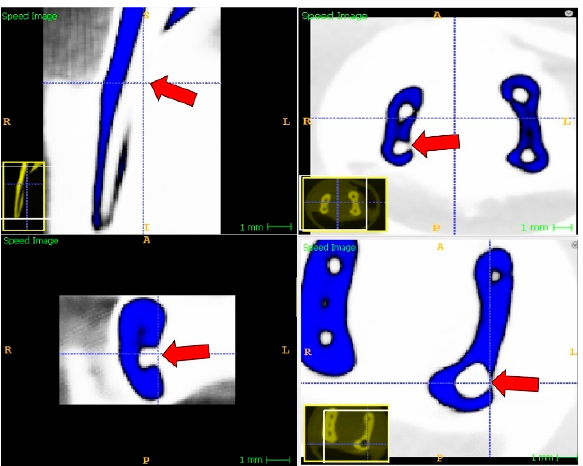
Figure 1. Speed images of perforated root canals that were excluded from the